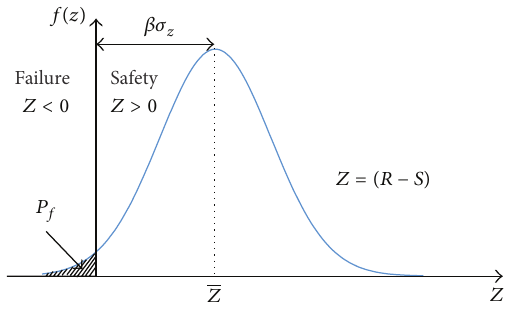
Figure 2: Safety margin